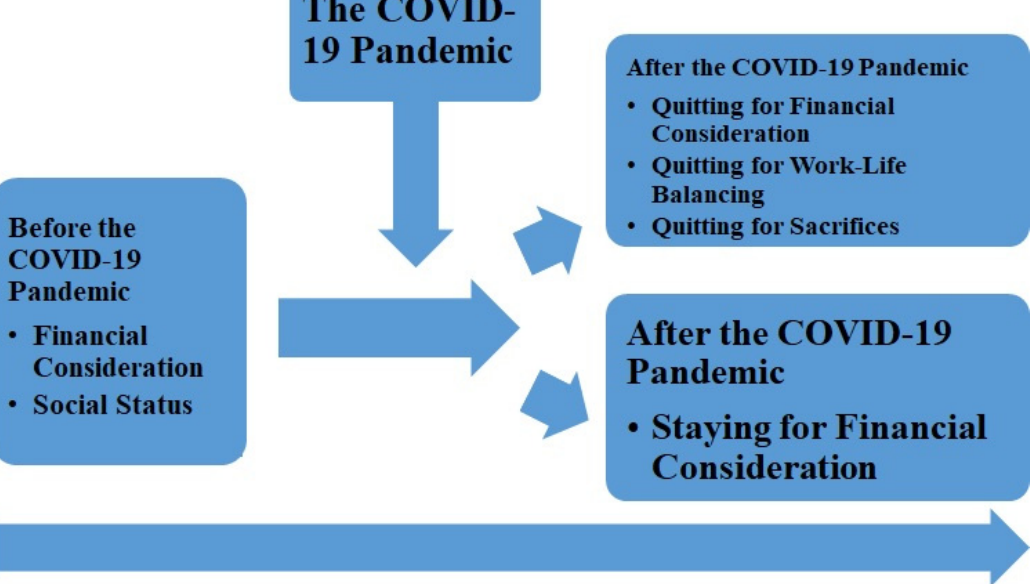
Figure 1. The relationship between the theoretical framework (i.e., the Social Cognitive Career Theory (SCCT)) and the outcomes.